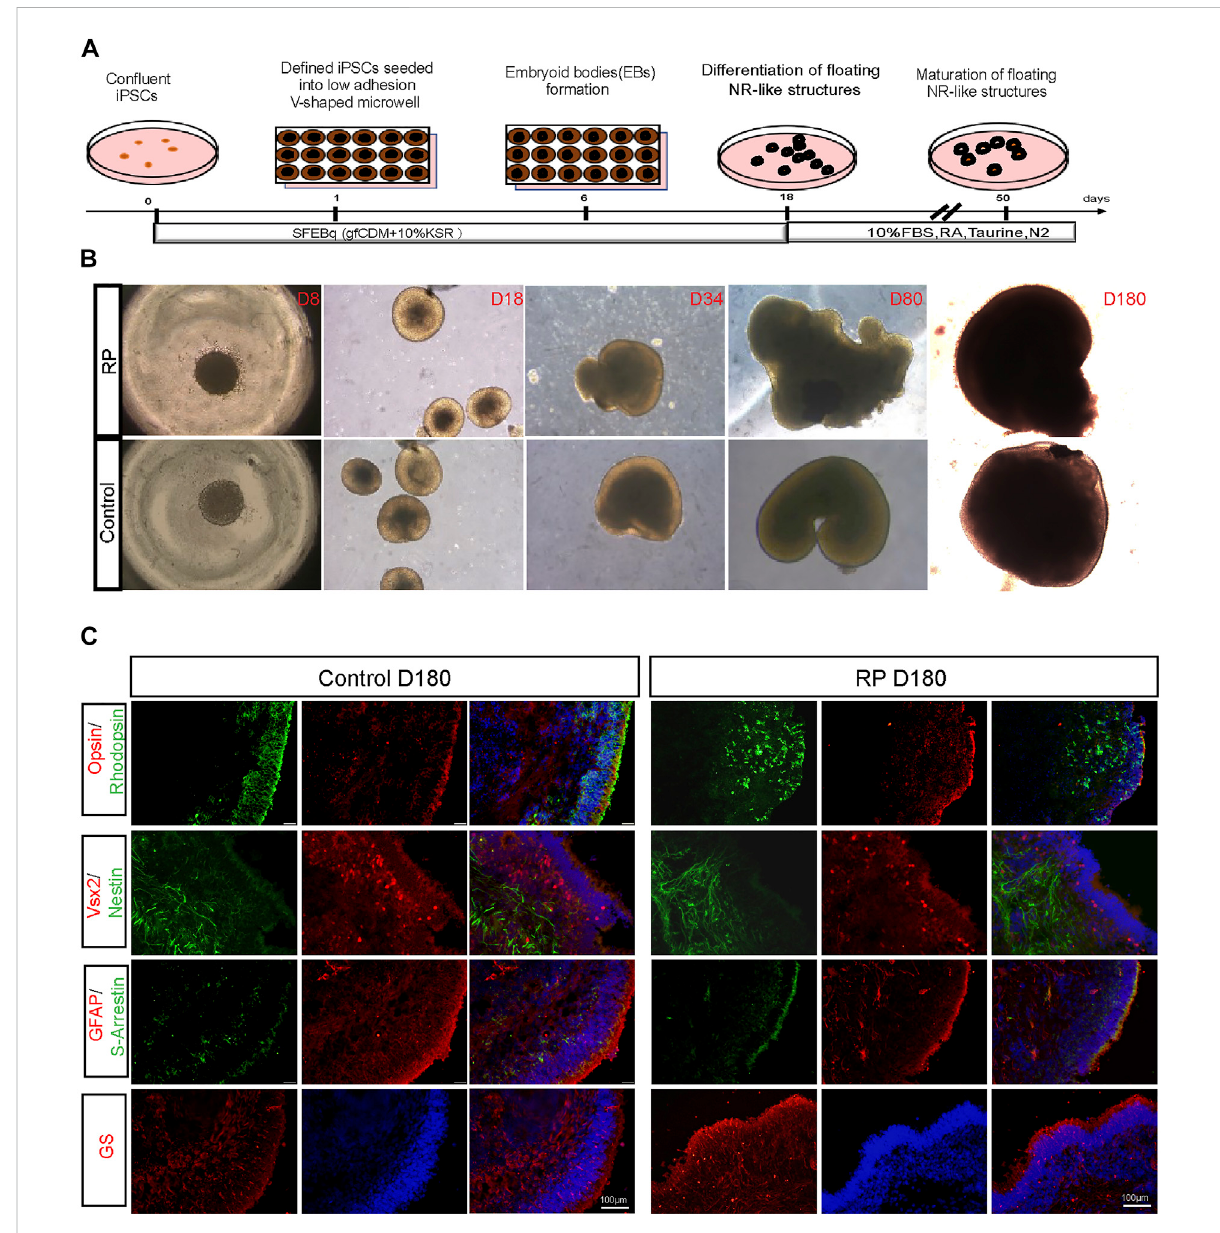
FIGURE 1 Generation of ROs derived from iPSCs with USH2A mutations. (A) Schematic representation of iPSCs differentiation along the ROs lineage. (B) BrightimagesofROsatD8-D180derivedfromRPiPSCsandNiPSCswithinductionofBMP4,taurineandretinoicacidatdifferenttimepoints(×5). (C) Immunostaining images of cytosections of ROs were positive for markers of rod (rhodopsin), cone (opsin and S-arrestin), müller (GS), astrocyte (GFAP) and retinal progenitor cells (VSX2 and